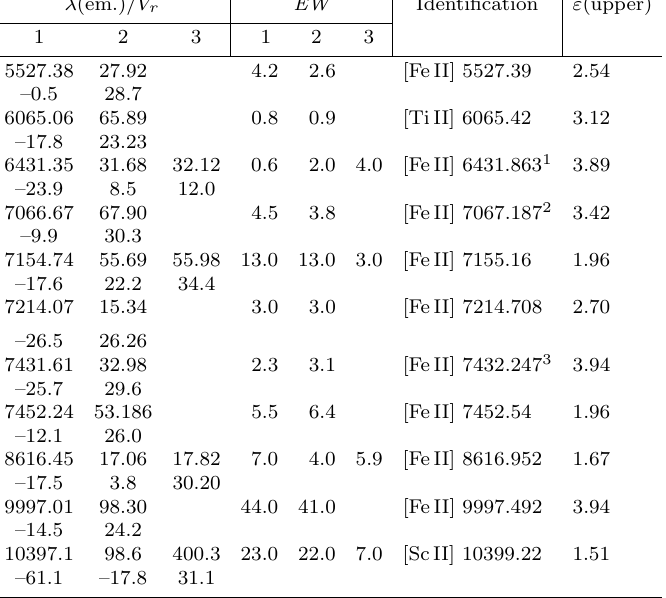
Table 6. The forbidden emission lines in the spectrum of υ Sgr. The emission components of each line is listed in two rows as in Table 5. λ (em.) /V r